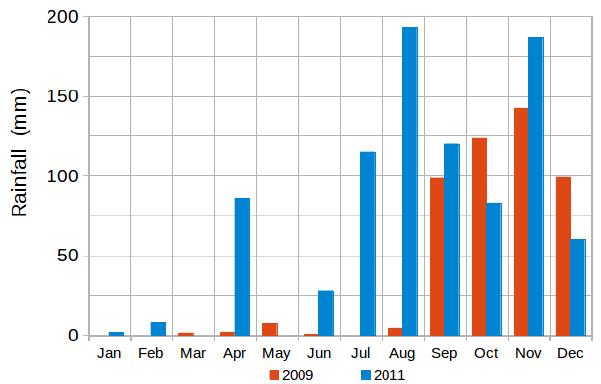
Figure 1. Monthly precipitation amounts over Gadanki during 2009 and 2011.